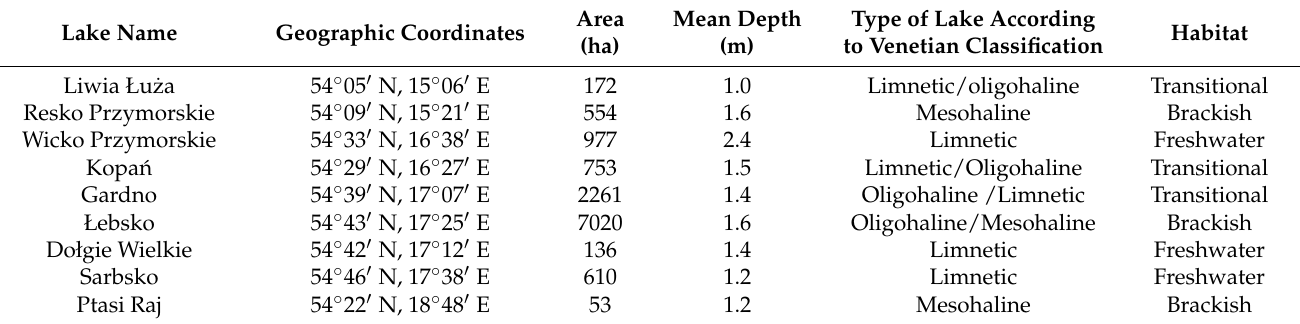
Table 1. Morphometric characteristics and classification of the studied coastal